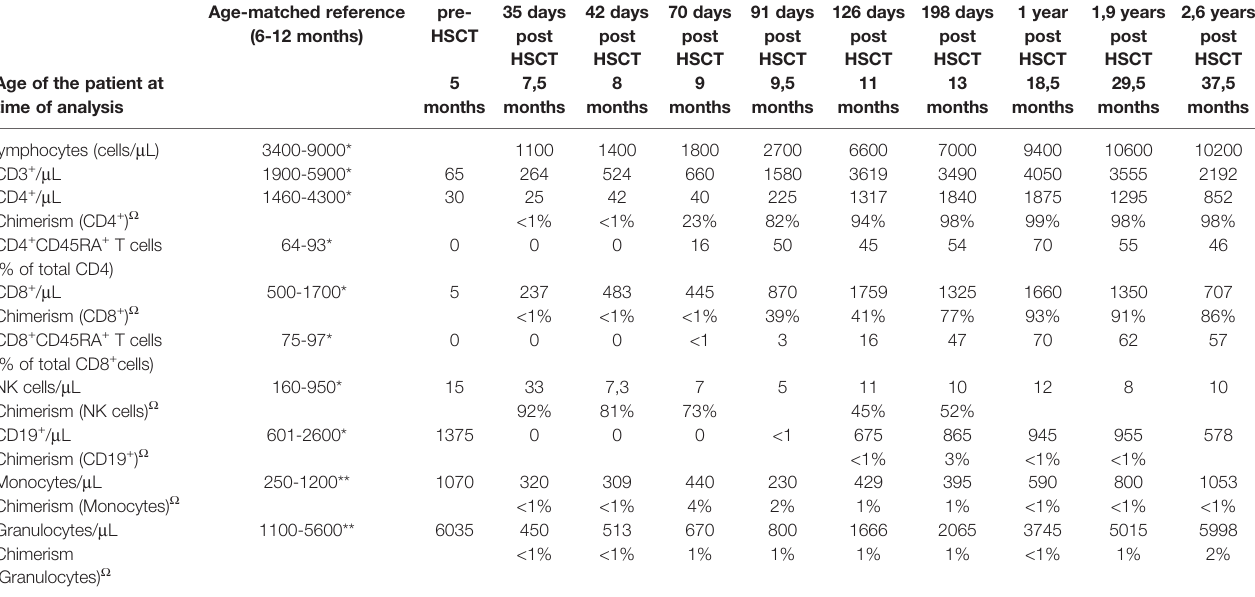
TABLE 1 | Laboratory parameters of our X-SCID patient prior to and after hematopoietic stem cell transplantation (HSCT) compared to an age matched healthy control cohort. *(19)**(20). Age-matched reference (6-12